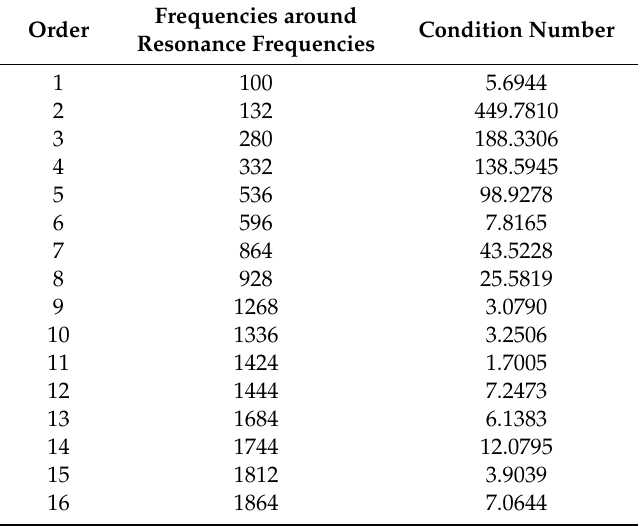
Table 7. Condition number of the structure’s frequencies around natural resonance